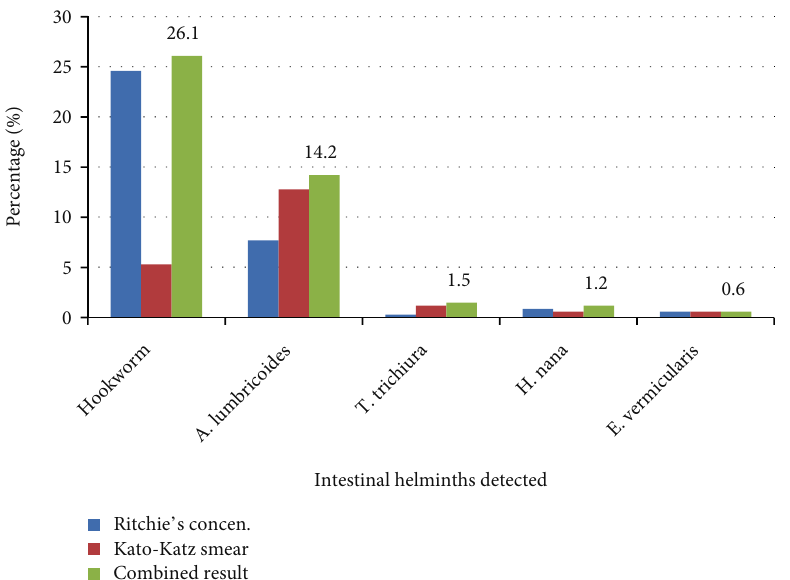
Figure 2: Prevalence of soil-transmitted helminth and other intestinal parasites detected using Kato – Katz and Ritchie ’ s concentration techniques among primary schoolchildren around Lake Tana,